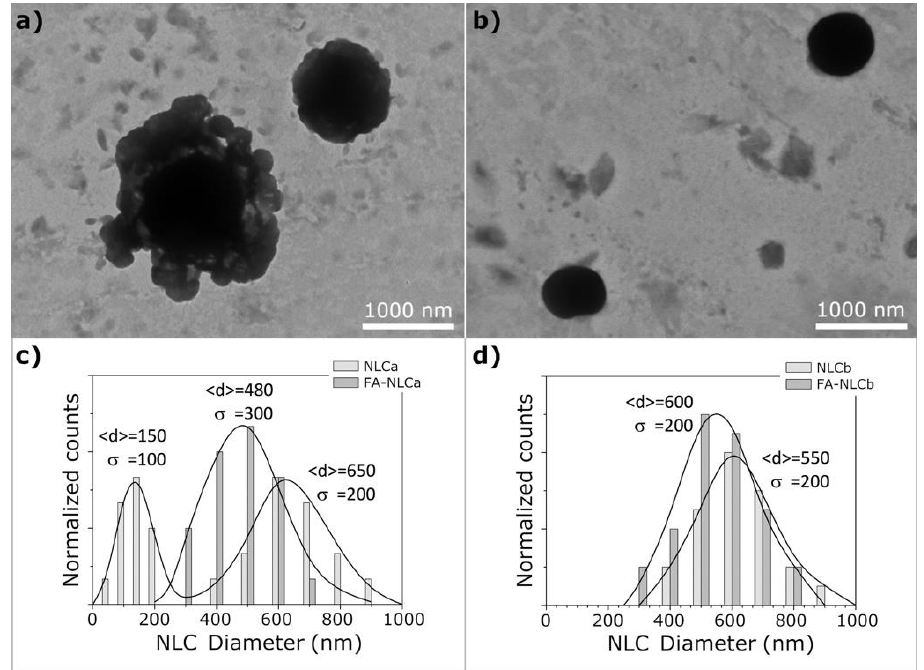
Figure 2. Transmission electron microscopy (TEM) images of NLCa ( a ) and NLCb ( b ). The histograms show the size distribution of the lipid nanoparticles in NLCa ( c ) and NLCb ( d ); continuous curves represent the Gaussian fit of experimental data and the parameters < d > (mean diameter) and σ (standard deviation) are also reported.